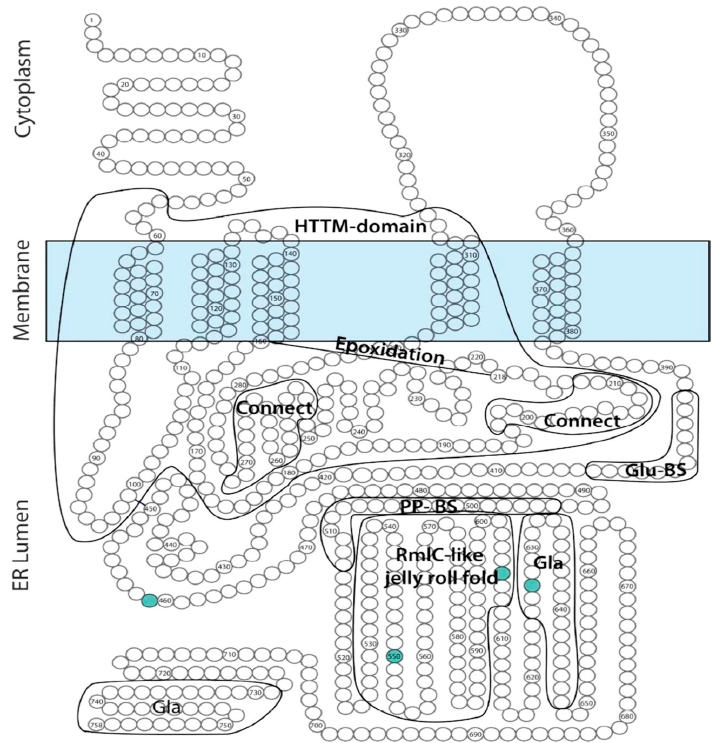
Figure 2. Predicted gamma-glutamyl carboxylase (GGCX) topology. Adapted from [9]. This figure